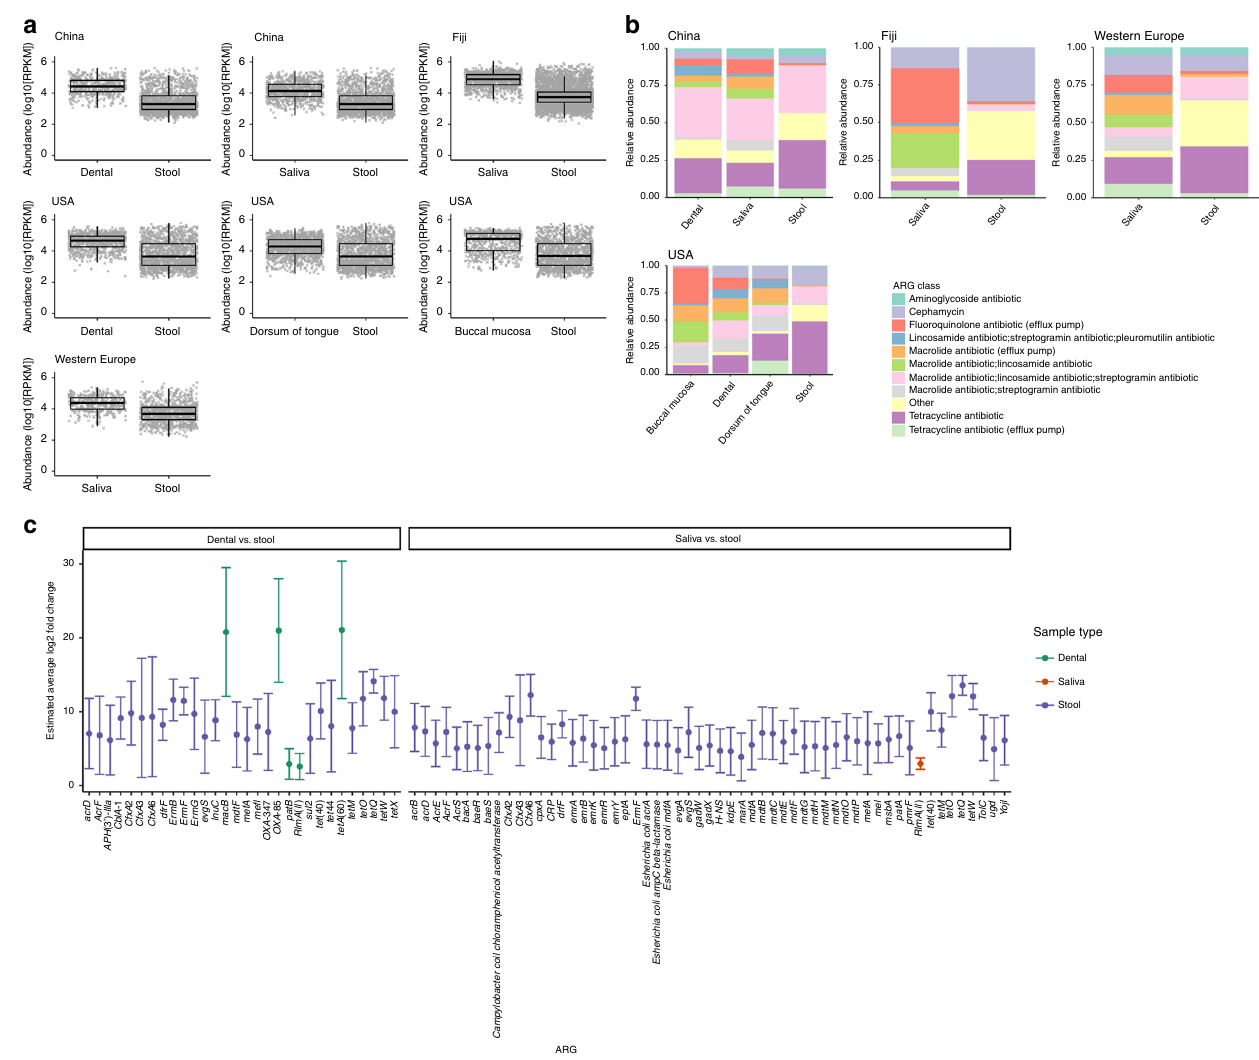
Fig. 3 Comparing ARG abundance between the oral cavity and gut. a Absolute abundance in log10 of reads per kilobase of read per million (RPKM) of ARGs for paired samples of individuals from China (stool and dental plaque: n = 30, stool and saliva: n = 31), Fiji (saliva and stool: n = 132), the USA (stool and dental plaque: n = 68, stool and dorsum of tongue: n = 69, stool and buccal mucosa: n = 64) and Western Europe (saliva and stool: n = 21). Centre line is median, box limits are upper and lower quartiles, whiskers are 1.5× interquartile ranges and points beyond whiskers are outliers. b Relative abundance of reads labelled by the top ten most abundant ARG classes across all geographical locations or other classes for each body site of individuals from China (dental plaque: n = 32, saliva: n = 33, stool: n = 72), Fiji (saliva: n = 136, stool: n = 137), the USA (buccal mucosa: n = 87, dental plaque: n = 90, dorsum of tongue: n = 91, stool: n = 70) and Western Europe (saliva: n = 21, stool: n = 21). c Estimated average log2 fold change of ARGs between paired dental plaque and stool, and saliva and stool samples using random effects meta-analysis across study cohorts ( p -value < 0.05). Error bars are 95% con fi dence intervals from meta-analysis. ARGs selected for meta-analysis where adjusted p -value < 0.05 from differential abundance analysis between paired samples of individuals from China (stool and dental plaque: n = 30, stool and saliva: n = 31), Fiji (saliva and stool: n = 132), the USA (stool and dental plaque: n = 68) and Western Europe (saliva and stool: n = 21). Source data are provided in the Source Data fi resistomes without antibiotics. Hierarchical clustering reveals that cohorts (Fig. 3a). The overall abundance is similar between paired the same individuals and body sites cluster together, verifying that US oral sites, with buccal mucosa and dental plaque having a resistomes at all sites remain stable over a prolonged period with slightly higher abundance than the tongue dorsum samples no antimicrobial selection pressure (Supplementary Fig. 2). (Supplementary Fig. 3). Oral samples contain a higher relative abundance of ARGs coding for fl uoroquinolone ef fl ux pumps, lincosamide/streptogramin/pleuromutilin resistance, macrolide ARG composition differs between the oral cavity and gut . To ef fl ux pumps and macrolide/lincosamide resistance than stool further investigate the differences between oral and gut resistome samples (Fig. 3b; Supplementary Fig. 4). These classes are mostly pro fi les, the abundance and diversity between oral and gut dominated by one of two ARGs across all cohorts, such as patB samples from China, Fiji, USA and Western Europe were eval- (coding for part of the PatA-PatB ef fl ux pump) in the fl uor- uated and compared. The total abundance, measured as the total oquinolone ef fl ux pump class (Supplementary Fig. 5a, b, c, d). reads per kilobase million (RPKM), of all ARGs in gut samples is Stool contains a higher proportion of tetracyclines and Other lower than in oral (buccal mucosa, dental plaque, dorsum of ARGs across all cohorts (Fig. 3b; Supplementary Fig. 4). These tongue and saliva) samples across all pairwise comparisons in all